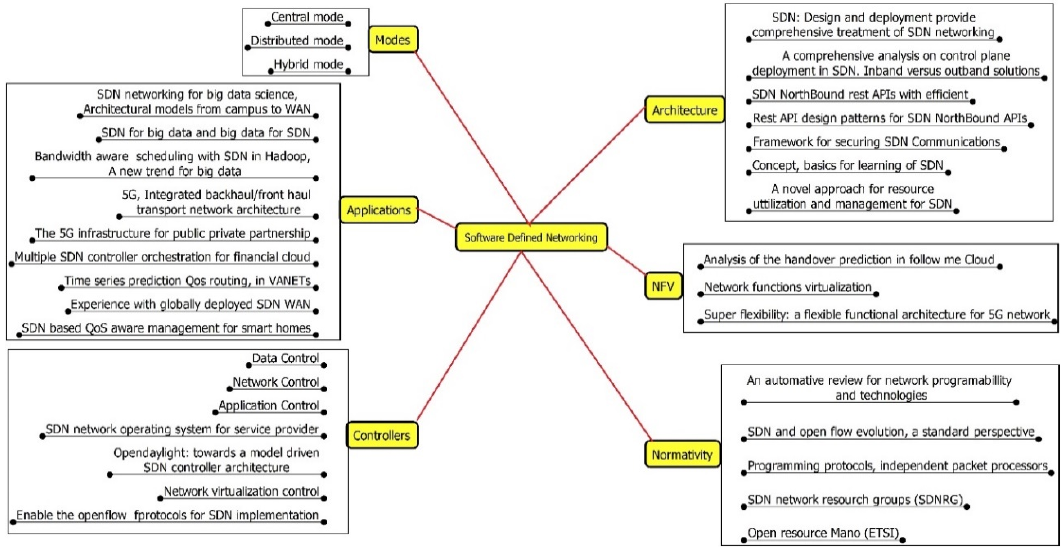
Figure 1. Architecture, modes, controllers, and applications of software defined networking (SDN).